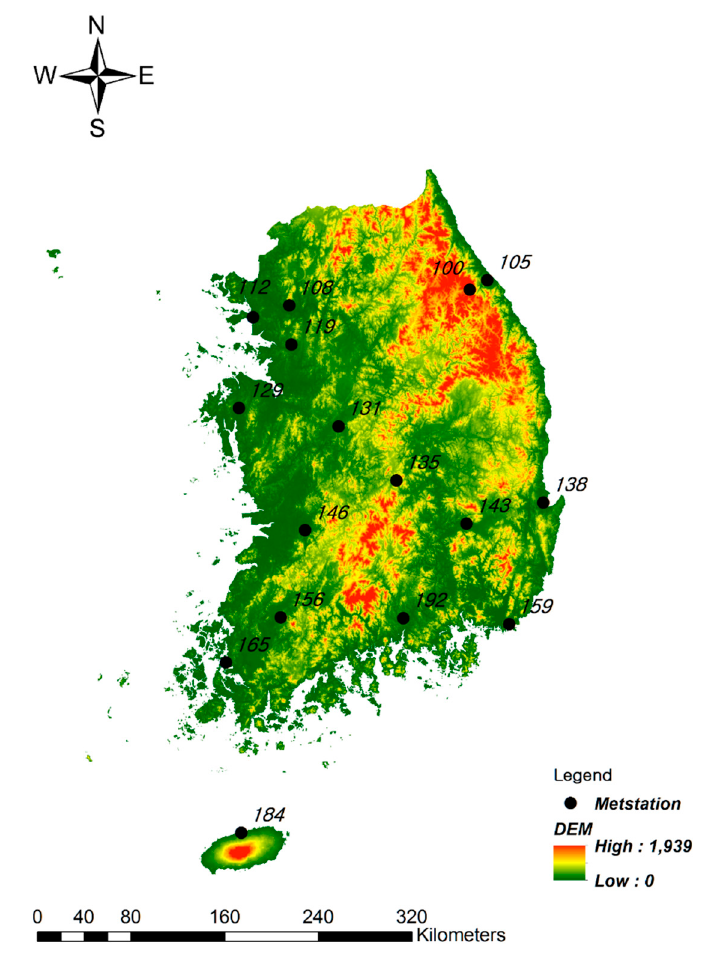
Figure 1. Location of the study sites.